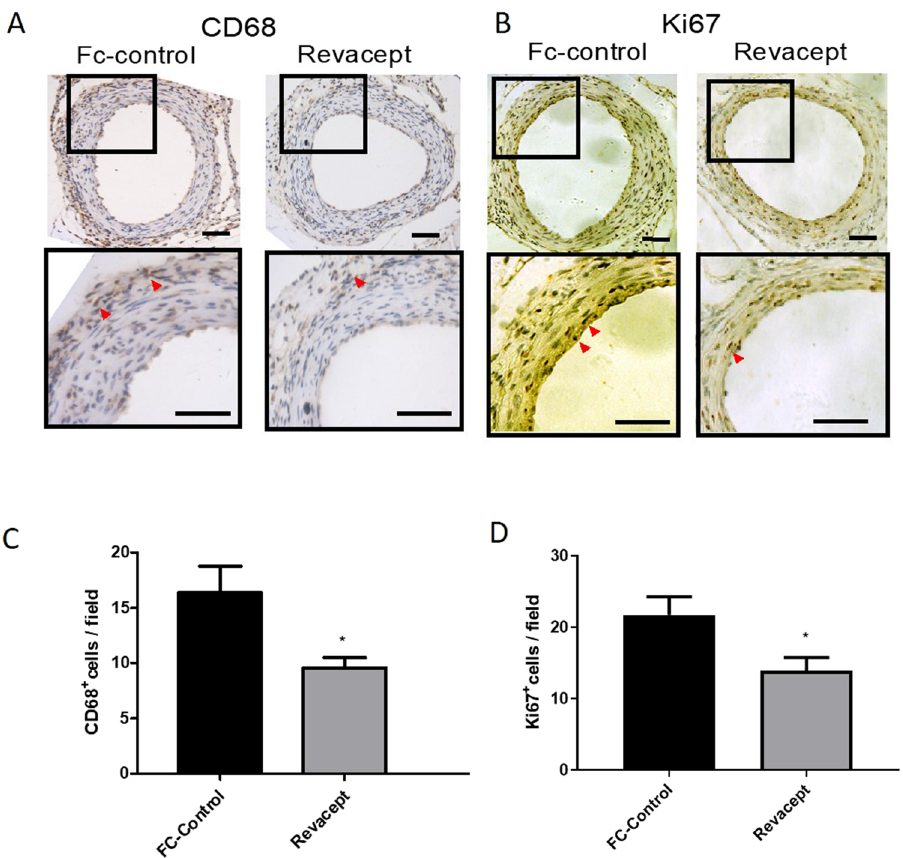
Figure 6. Effects of Revacept administration to mice on CD68 and Ki67 expression in femoral artery sections. ( A , B ) Immunohistochemistry of femoral artery sections to assess CD68 and Ki67 at 28 days after surgery in mice treated with Revacept or Fc. ( C , D ) CD 68 + and Ki67 + cells per field are presented as mean ± SEM, n = 4 mice; * P < 0.05 versus Fc-control, (using Student’s t-test). Scale bar = 50